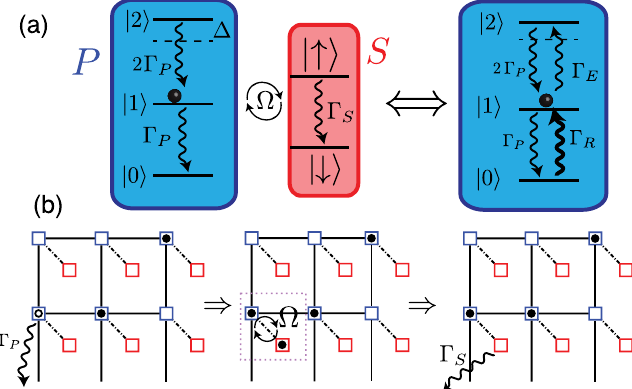
FIG. 1. (a) Simple example of dissipative protection of a quantum state. We consider a nonlinear resonator P , coupled to an auxilliary “ shadow ” spin S , and we wish to hold the resonator in the one-photon state j 1 against a loss rate Γ . We do so by coupling the P i P resonator and shadow spin with a two-photon drive Ω , which resonantly adds a photon to the resonator and excites the spin or removes a photon from the resonator and returns the spin to its ground state. The nonlinearity Δ ≫ Ω suppresses the j 1 i → j 2 i transition, and if the ≫ Γ shadow spin has a fast relaxation rate Γ , then j 1 ; ↓ i is the most stable state of the system and all other configurations will rapidly S P relax toward it, as described in the Introduction. (b) Many-body generalization of this mechanism to protect a lattice fractional quantum Hall system (blue) from losses. The primary quantum Hall lattice is coupled to a shadow lattice (red) through a two-photon drive field, so that when a many-body hole excitation is created by a photon loss on the primary lattice (rate Γ ), it is resonantly mixed with a particle P excitation on the shadow lattice (rate Ω ), which rapidly decays (rate Γ ), returning the primary lattice to its many-body ground state. S ≫ Γ If Γ and Ω ≫ Γ , holes will be refilled much more quickly than they are created, and the fractional quantum Hall ground state S P P becomes the most stable state of the system. The many-body gap of the topological ground state suppresses further particle addition once the fractional quantum Hall state is